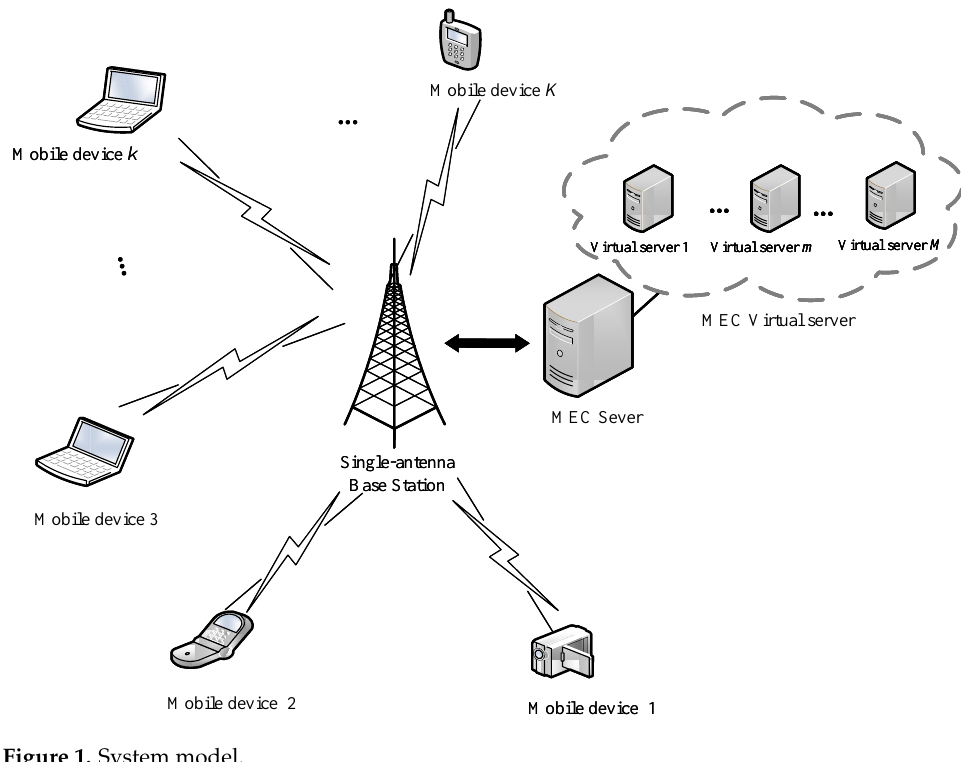
Figure 1. System